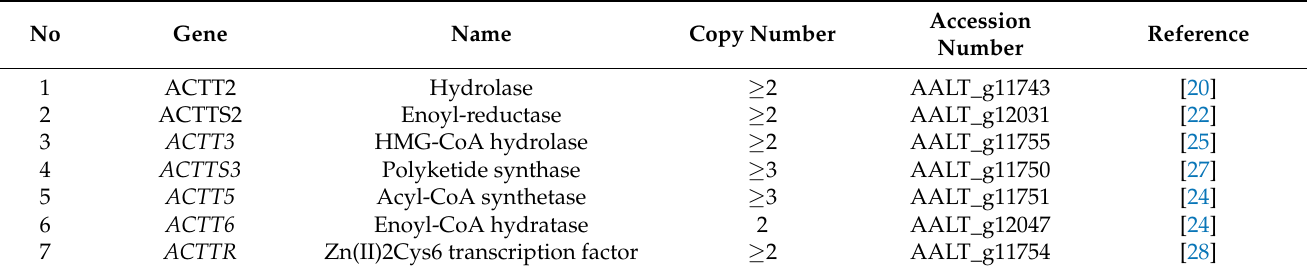
Table 3. Key genes essential for ACT biosynthesis.